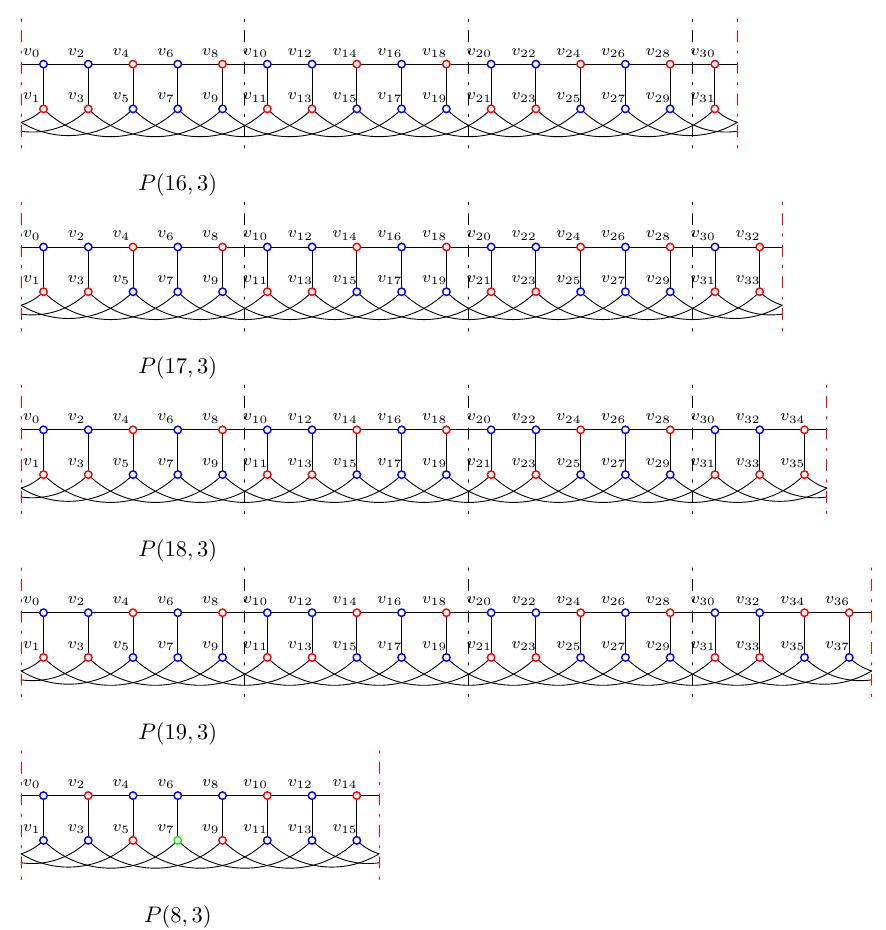
Figure 3. The function f on P ( n ,3 ) ( n = 16,17,18,19,8 ) .